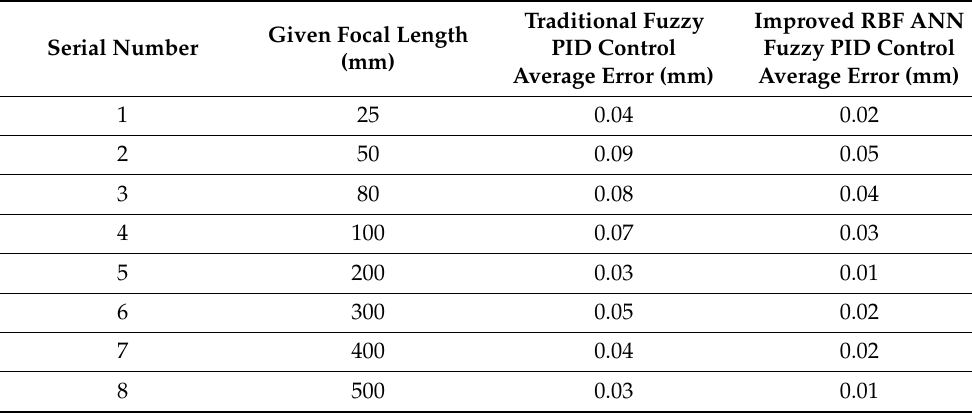
Table 2. Focal length